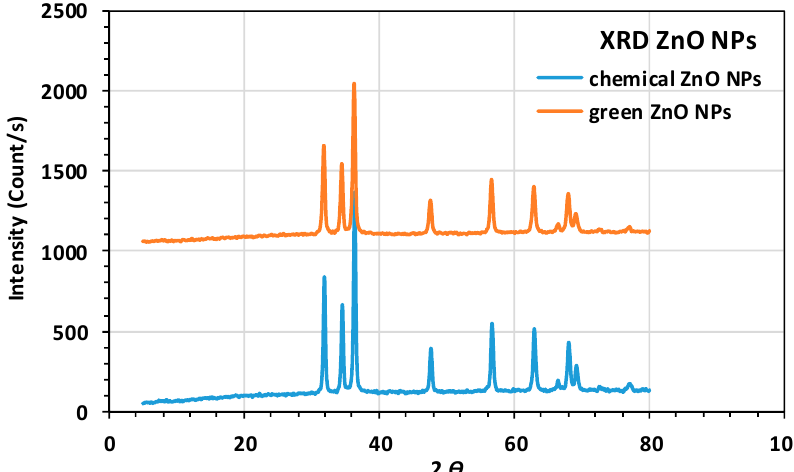
Figure 9. X-ray di ff ractograms of chemical and green synthesized ZnO Figure 9. X-ray diffractograms of chemical and green synthesized ZnO NPs. Figure 9. X-ray diffractograms of chemical and green synthesized ZnO NPs.